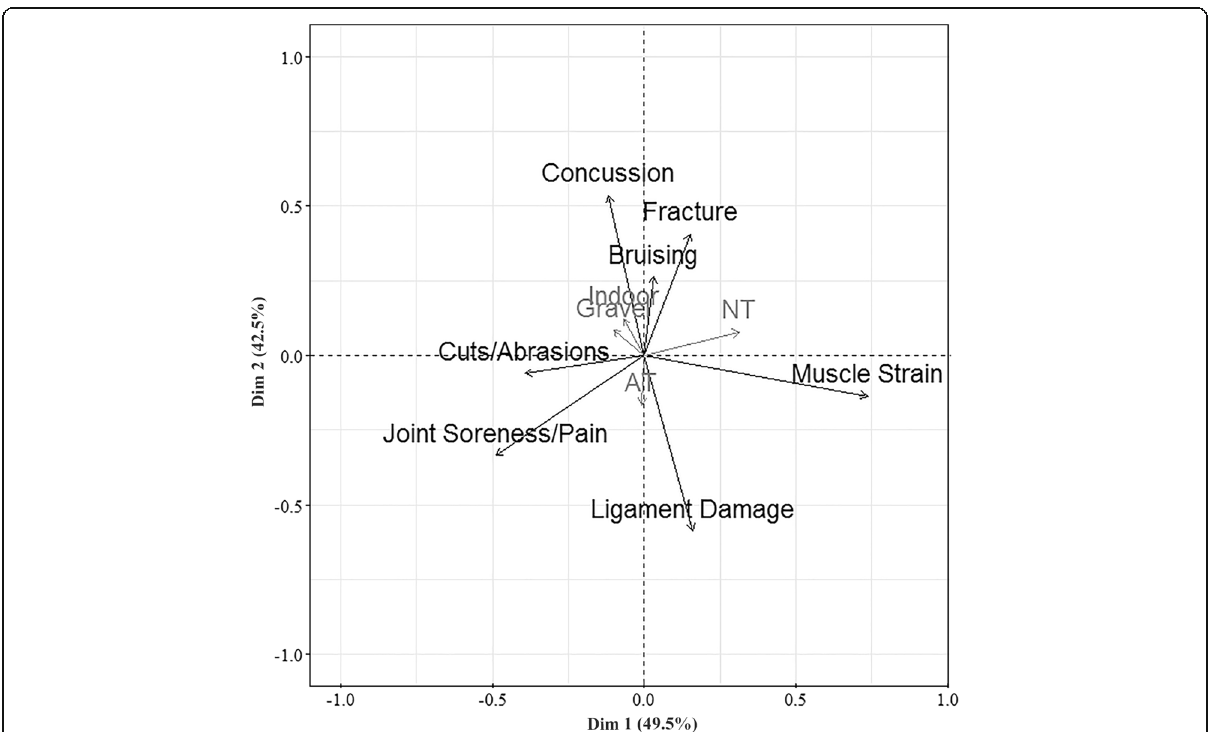
Fig. 5 Asymmetric contributing plot of types of injuries (black) linked to different playing surfaces (grey). Playing surfaces that contribute little to the dimensions are close to the centre of the plot (i.e. shorter arrows)